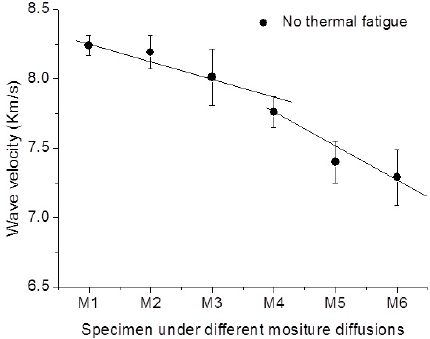
Figure 6. Variation of wave velocity in the specimen, which subjected no thermal fatigue, in different moisture diffusional states.